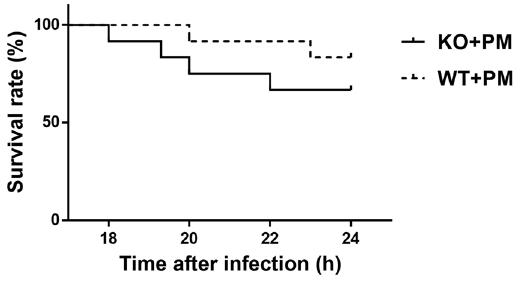
Figure 1. Kaplan-Meier curves showing the survival rates of mice with PM. Survival rate of myd88 − / − and wild-type mice following S. pneumoniae infection were 66.7% and 83.3%, respectively. KO: knockout, PM: pneumoniae meningitis, WT: wild-type.